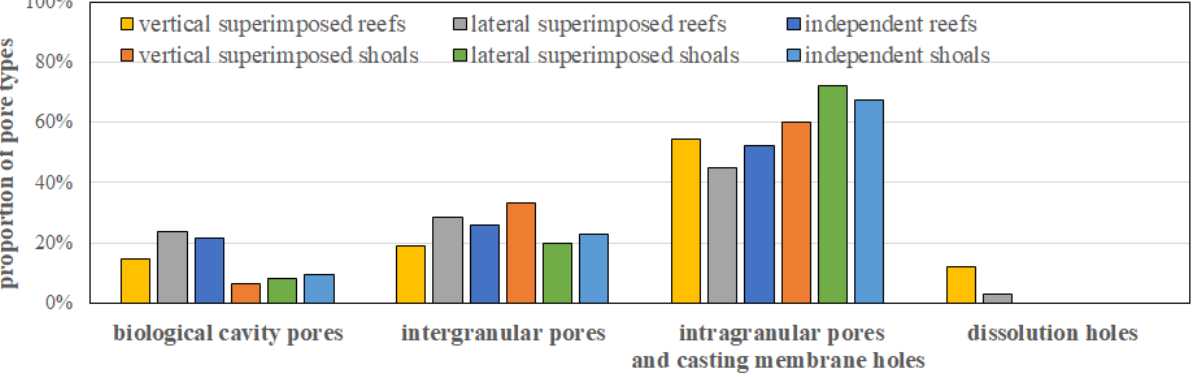
Figure 9. Dissolution cavities characteristics of various architecture types.